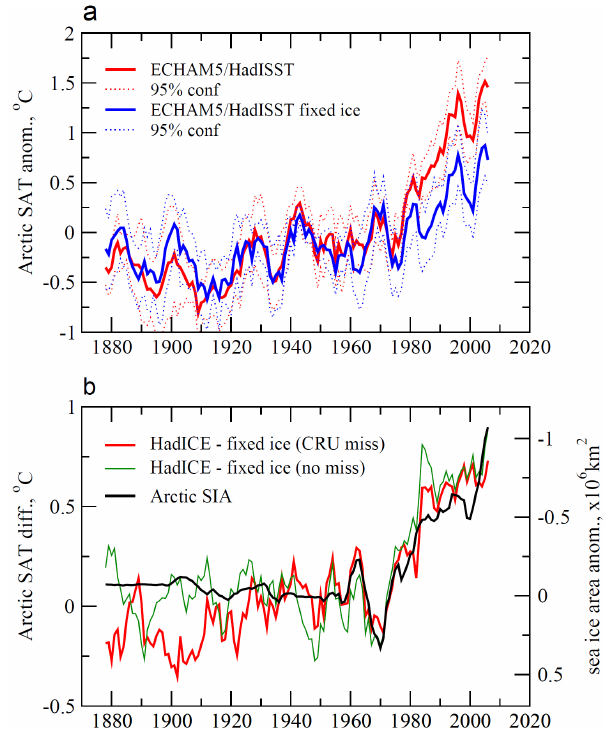
Fig. 4. (a) Arctic land SAT cold season anomalies ( ◦ C) as simulated in the HadISST (red) and HadISST-fixed ice ensemble (blue). The ensemble means are given as solid bold lines, the confidence inter- vals as thin dashed lines; (b) difference between the ensemble mean SATs shown in (a) with (red) and without (green) data sampling ac- cording to CRUTEM3 data. The black line depicts the inverted (see right y-axis) sea ice area differences (10 6 km 2 ) (HadISST1.1 – cli- matology of the period 1941–1950). All time series are smoothed with a 5-yr running mean filter.